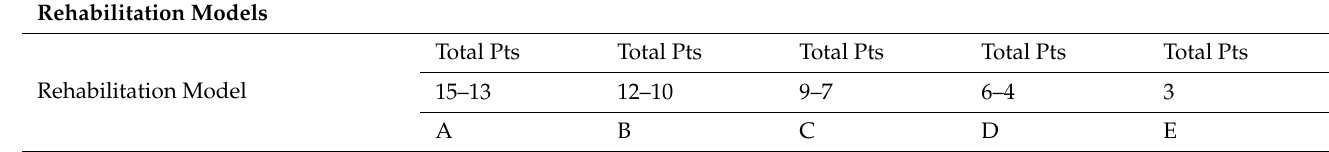
Table 4. Qualification Card for the post-COVID-19 Rehabilitation Program used by physical therapists, part